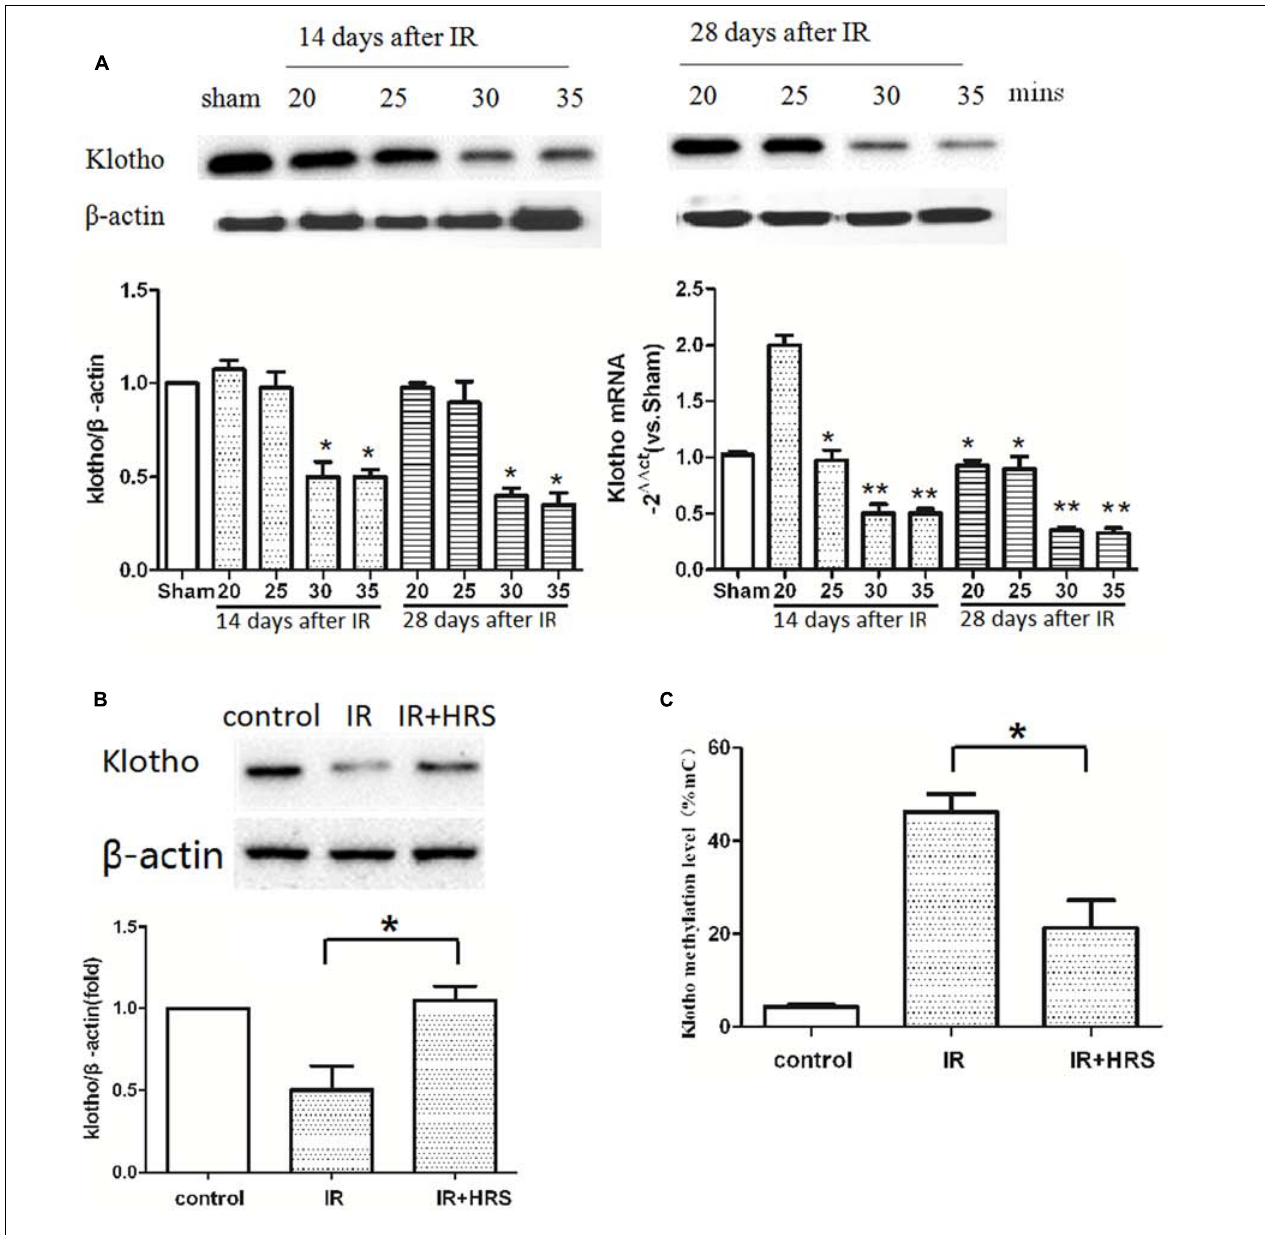
FIGURE 2 | HRS unregulated Klotho expression and methylation level. (A) Renal Klotho levels at 14 and 28 days after IR in 20/25/30/35-min ischemia models. The protein level of renal Klotho was decreased at about 14 days after IR in 30-min ischemia models, with subsequent decrease until 28 days after the injury ( ∗ P < 0.05). The gene expression of Klotho in 20-min ischemia models was significantly higher than the normal condition of the sham group at 14 days after IR, and this increase was abolished at 28 days after the injury (A) (compared with sham group, ∗ P < 0.05). Both 30- and 35-min groups showed decreased Klotho gene expression at 14 days (compared with sham group, ∗∗ P < 0.01). At 28 days, Klotho gene expression showed a decreasing trend in 30-min models whereas it remained at a lower level in 35-min models (compared with sham group, ∗∗ P < 0.01). (B) The expression of renal Klotho was sharply increased in HRS group (compared with IR group, ∗ P < 0.05). (C) The methylation level of Klotho in HRS group was decreased (compared with IR group, ∗ P <